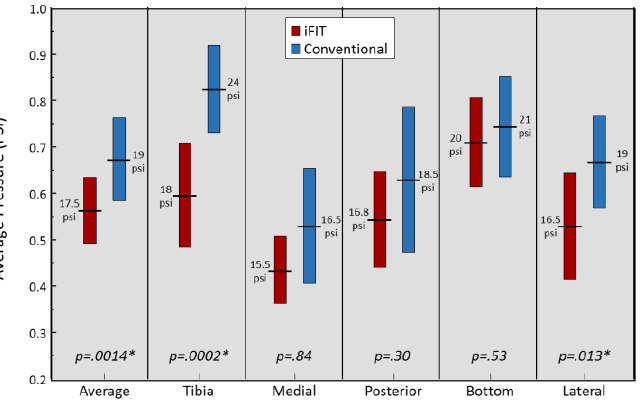
Figure 1. Average Peak Pressure: iFIT versus Conventional Prosthesis. An estimated pressure in pounds/square inch (psi) is indicated next to the mean values and reflects an estimated pressure as determined through nomographic scoring (Fujifilm ). These are peak pressures that occurred with